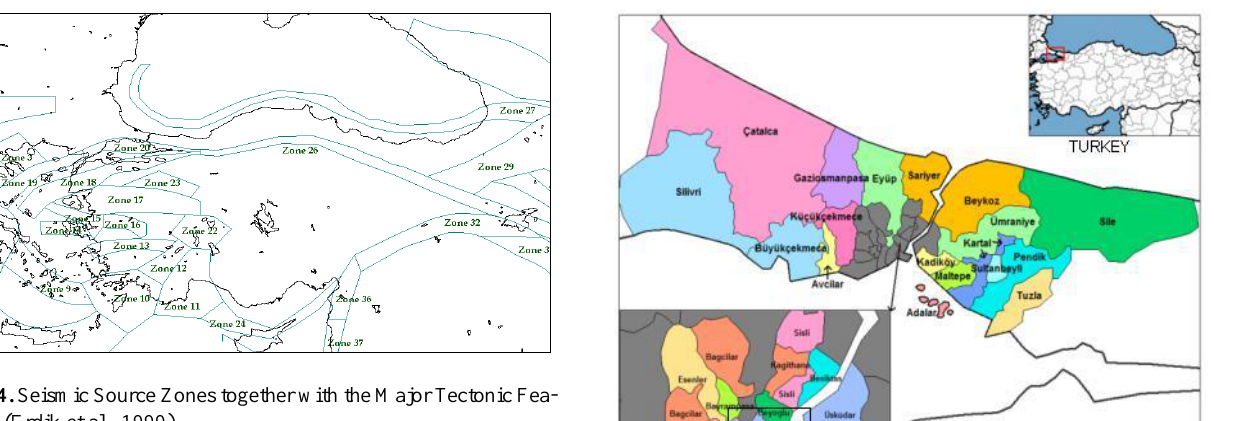
Table 1. The recurrence relations obtained from the GSHAP project (GSHAP, 1999).